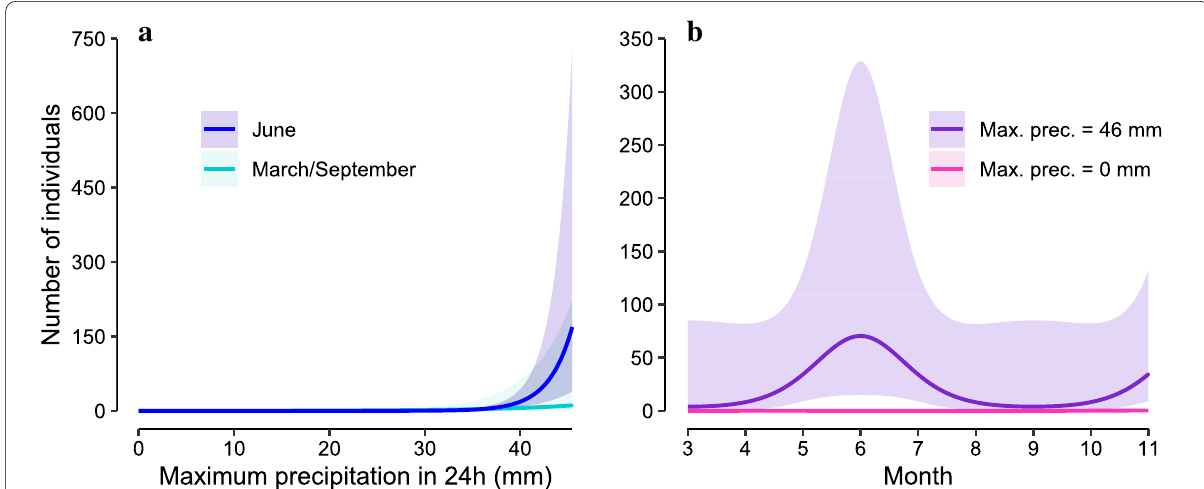
Fig. 2 Model predictions for rain and month effects. Lines indicate the predictions, shaded area the 95 % confidence interval (CI), ranges of independent variable shown only include values with actual observations. Rain (i.e. maximum precipitation in 24 h) had significant main effects on spadefoot toad numbers, however, the effect was strongest in June ( a ). To visualize the seasonal effects, we back‑transformed the trigonometric functions to months and averaged the effects, as well as the CI. We observed a striking increase of toad activity in June with intense rainfalls ( b ). Main effects of month and temperature only had minor effects (< 1 individuals) on toad activity (see Additional file 1: Fig